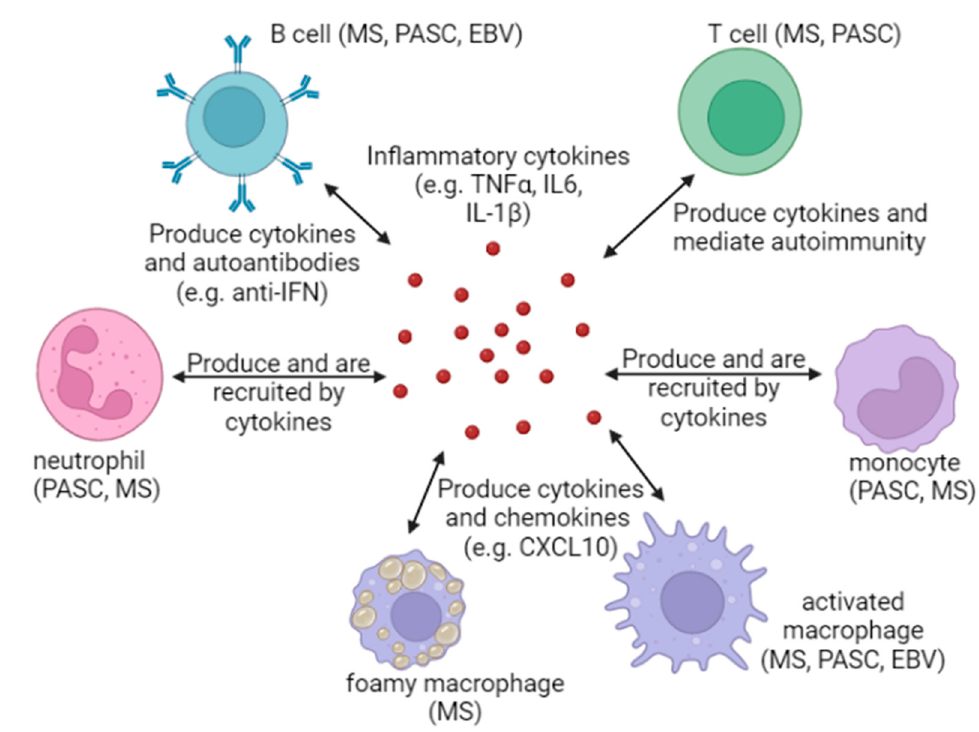
Figure 2. Innate and adaptive immune cells play a role in maintaining a state of inflammation frequently characterized by increased levels of cytokines. Some PASC patients have higher levels of neutrophils, which could promote an inflammatory state as they produce cytokines and are recruited by them. High levels of primed neutrophils have been observed in MS patients. Macrophages can have an anti-inflammatory effect early in MS, but as they become glutted with myelin, they can adopt a foamy, pro-inflammatory phenotype. Macrophages could also promote inflammation in MS via EBV exosomes. Macrophages may support inflammation in PASC through the production of cytokines and subsequent recruitment of more macrophages. Monocytes may have a pro-inflammatory effect in MS, especially by weakening the blood–brain barrier early in the disease. Monocytes in PASC patients may carry viral antigens long after the initial infection has resolved; higher numbers of pro-inflammatory classical monocytes were observed in some PASC patients early in recovery. T cells high in TNF α are carried by some PASC patients, which could provoke inflammation. In MS, T cells are known to recruit many other cell types into the brain and maintain a heightened state of inflammation that leads to plaque formation. B cells contribute to MS through molecular mimicry. Similarly, B cell production of autoantibodies to levels that are harmful could drive tissue damage and an increase in cytokines from damaged cells. B cells themselves are also known to produce cytokines. Image created in Biorender.com accessed on 11 April